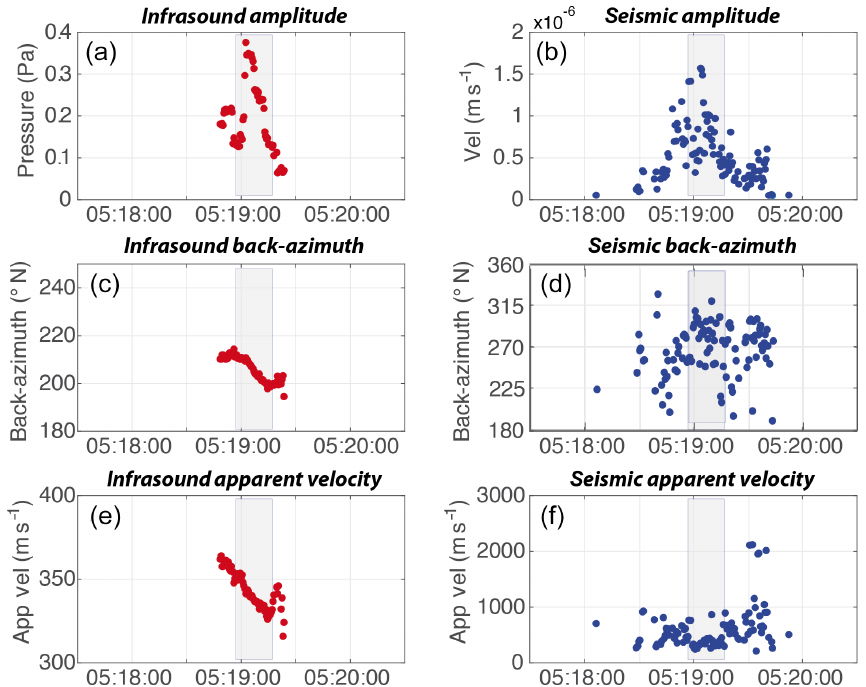
Figure 6. Amplitude, back-azimuth and apparent velocity of infrasound (a, c, e,) and seismic (b, d, f,) detections for the avalanche of 5 February 2016. The shaded area highlights the time window of sound propagation velocity recorded for the seismic